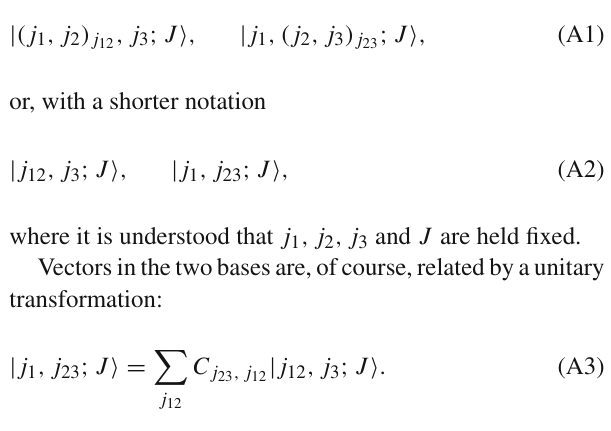
Table 6 Spin composition, couplings and tentative masses (in MeV) of the particles in the P -wave supermultiplet, in addition to the states in Table 1. Mass formulae are derived from Eq. (9), with M 00 , a Y , b Y taken from the second line of Table 4 and κ cq = 67 MeV. N 1 is the number of spin-1 “bad” diquarks, defined in Eq. (10)